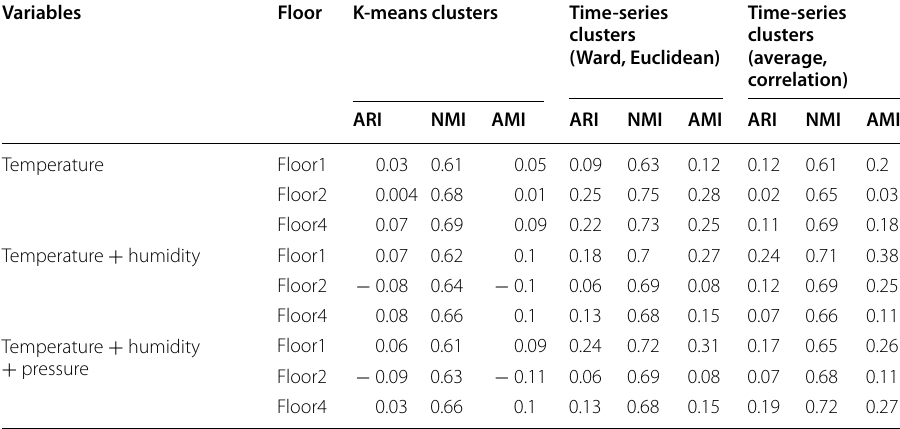
Table 3 Similarity scores when comparing zoning labels with cluster results Variables Floor K‑means clusters